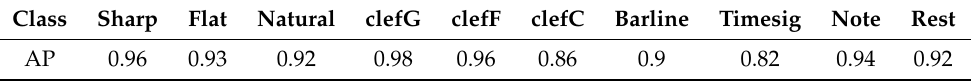
Table 1. Results in terms of Average Precision(AP)(%) with respect to the dataset (MuseScore). Class